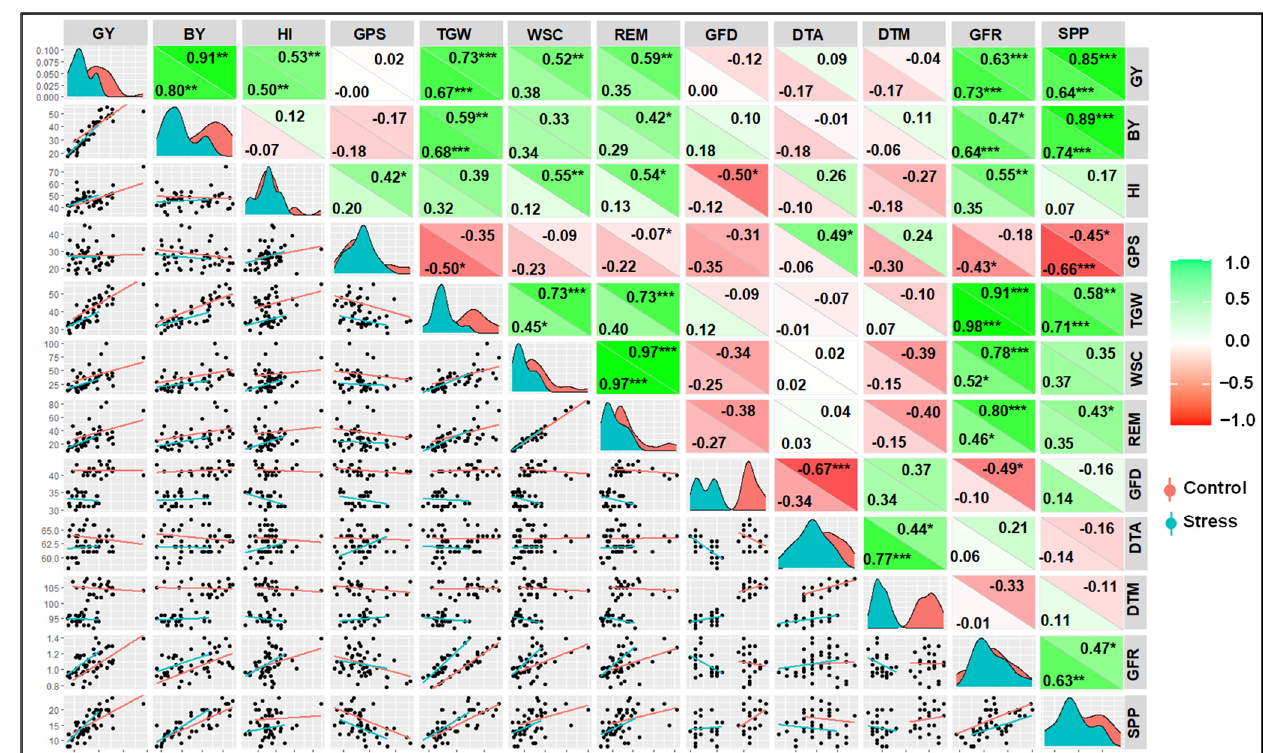
Figure 7. Scatterplot, correlation matrix and distribution data of the studied traits in eight pot-grown wheat cultivars both under control and post-anthesis drought stress. The upper-right panel shows a correlation matrix of different traits; each small rectangle is diagonally divided into lower-left and upper-right triangles that carry correlation information for a paired trait under control and drought stress, respectively. The diagonal panel indicates the normal distribution curve of correlated traits under control and drought stress. The lower-left panel indicates scatterplots and trend lines of the correlated traits under control and stress. *, ** and *** indicate significant at p < 0.05, p < 0.01 and p < 0.001. (GY—grain yield (g pot − 1 ); BY—biomass yield (cm pot − 1 ); HI—harvest index (%); GPS—grain per spike (no); TGW—thousand-grain weight (g); WSC—Water-soluble carbohydrates in culm at milk ripe stage (mg g − 1 DW); REM—Amount of remobilized WSCs (mg mg − 1 Culm DW); GFD—grain filling duration (d); DTA—days to anthesis (d); DTM—days to maturity (d); GFR—grain filling rate (mg grain − 1 d − 1 ); SPP—spike per pot).